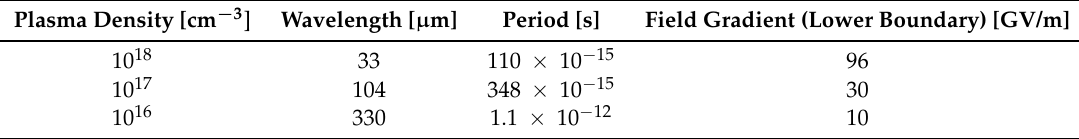
Table 2. Examples of electric field parameters for different plasma densities estimated using the equations